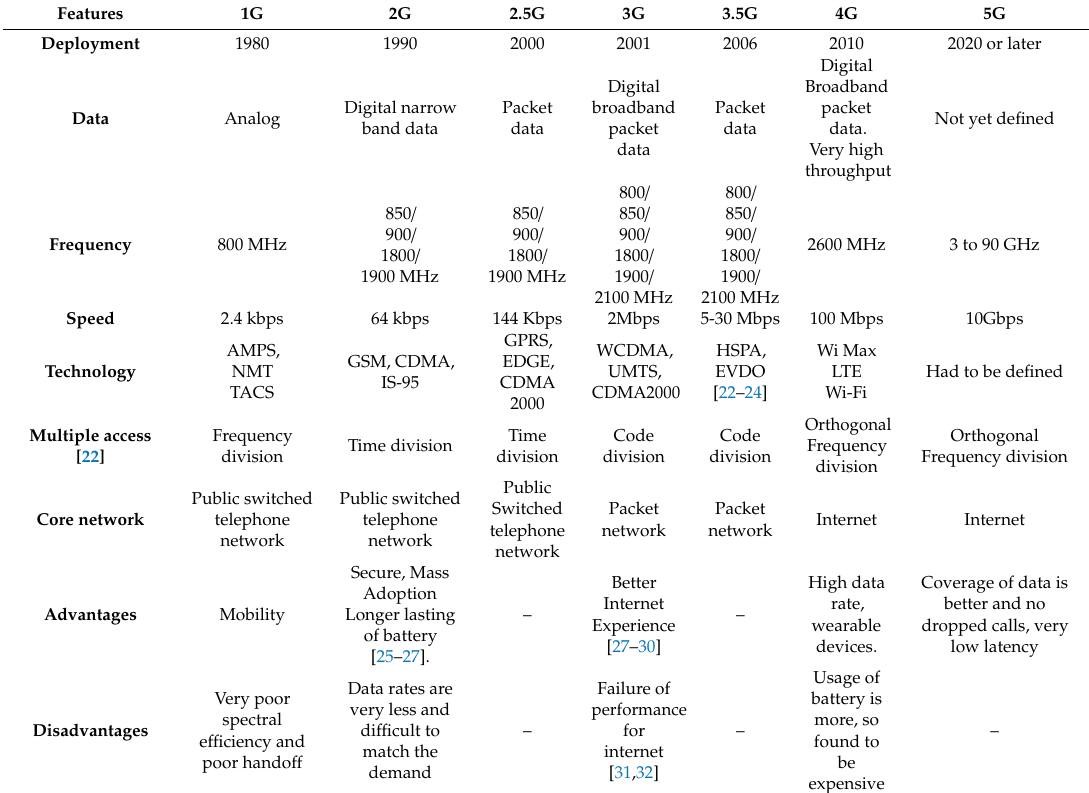
Table 1. Wireless communication technologies